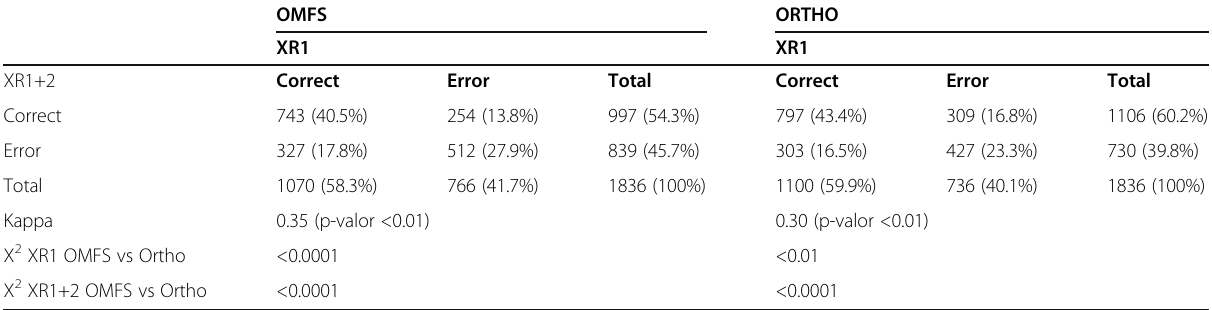
Table 2 Frequency and difference of the responses indicated by oralmaxillofacial surgeons (OMFS) and orthodontists (ORTHO) when evaluating all lower third molars, erupted spontaneously or impacted (n = 68), after analysis of one (XR1) or two serial